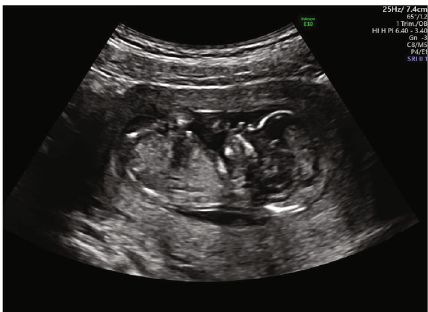
Figure 1: Gray-scale ultrasonography at the 13 weeks of gestation. Severe oligohydramnios was noted.